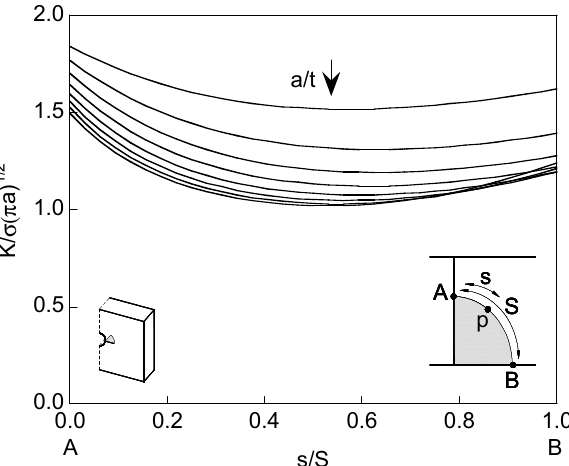
Figure 15. Dimensionless SIF along the crack front for the preferential fatigue propagation path (corrosion fatigue; cracks emanating from a hole with r = 0.5 t ).